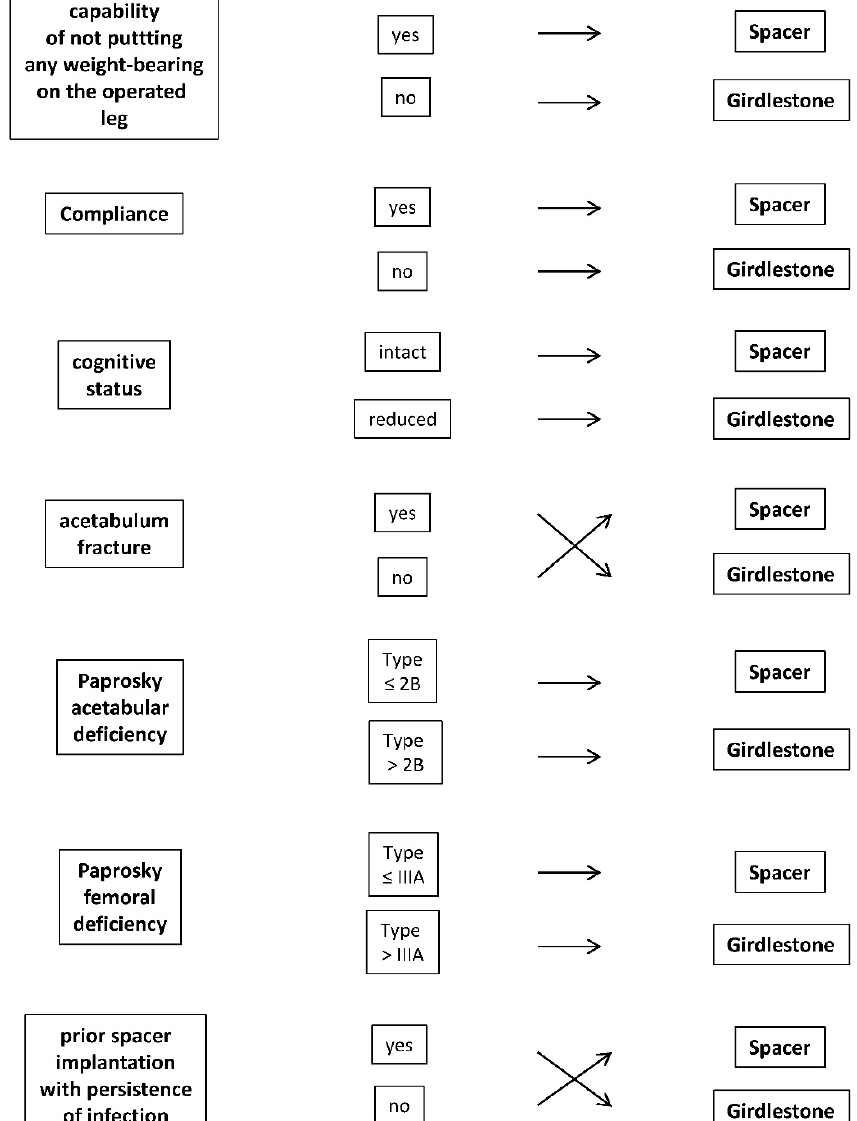
Figure 1: Criteria for differentiation between spacer implantation and Girdlestone arthroplasty for the management of late implant-associated hip joint